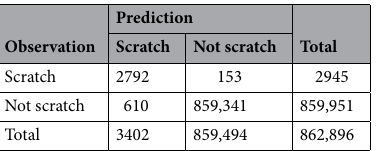
Table 3. Confusion matrix for dermatitis-induced scratching.